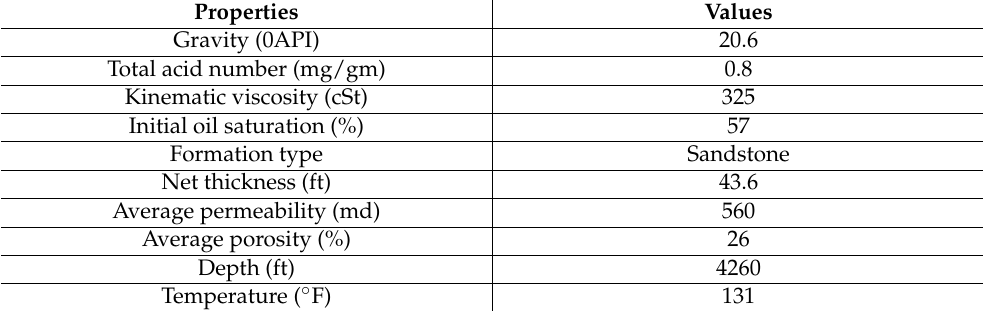
Table 5. Field and fluid properties of Shengli oil field,